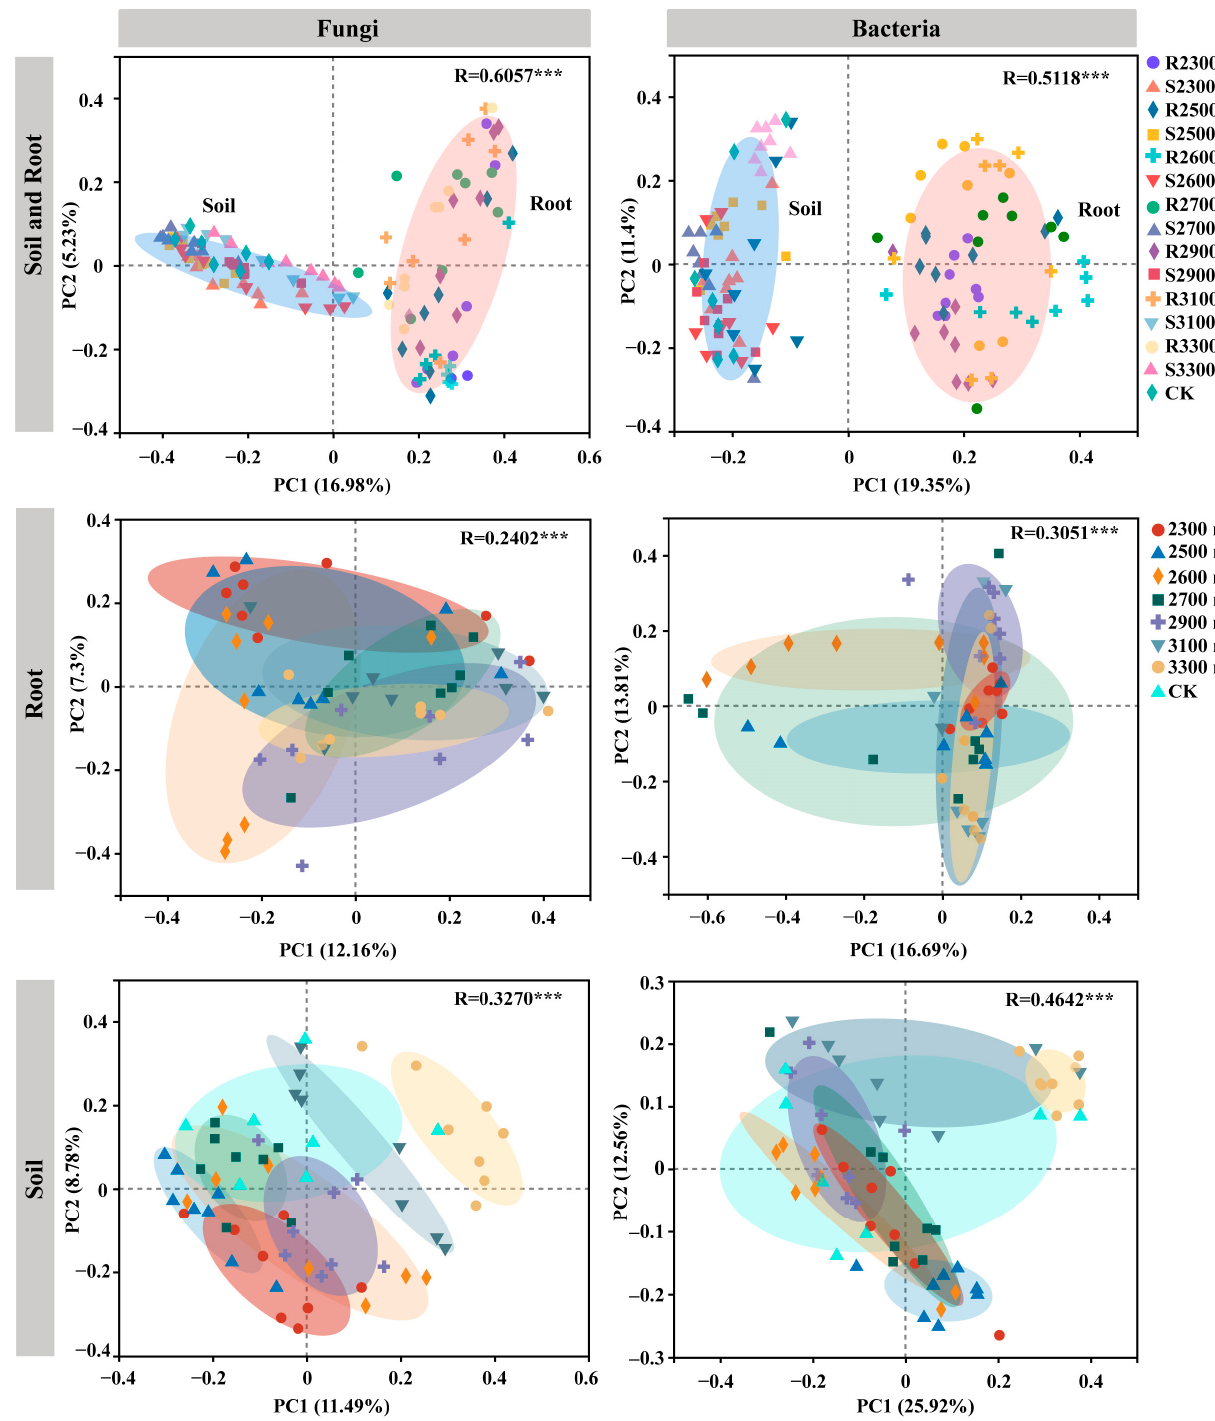
Figure 3. PCoA of the microbial communities of pine roots at different elevations. Significant difference: *** p ≤ 0.001.